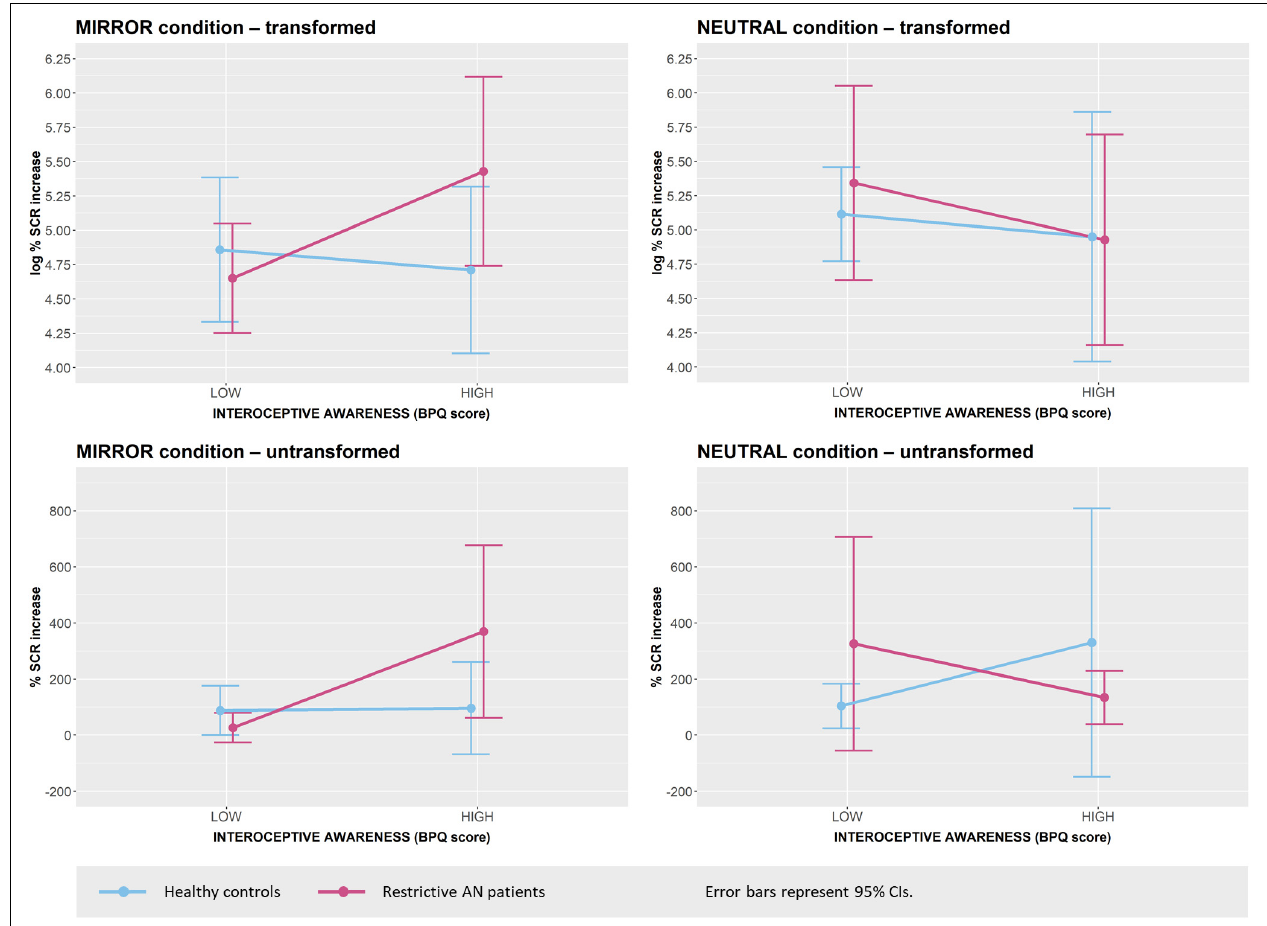
FIGURE 4 | Increase in SCR during the MIRROR condition and the NEUTRAL condition by group and level of interoceptive